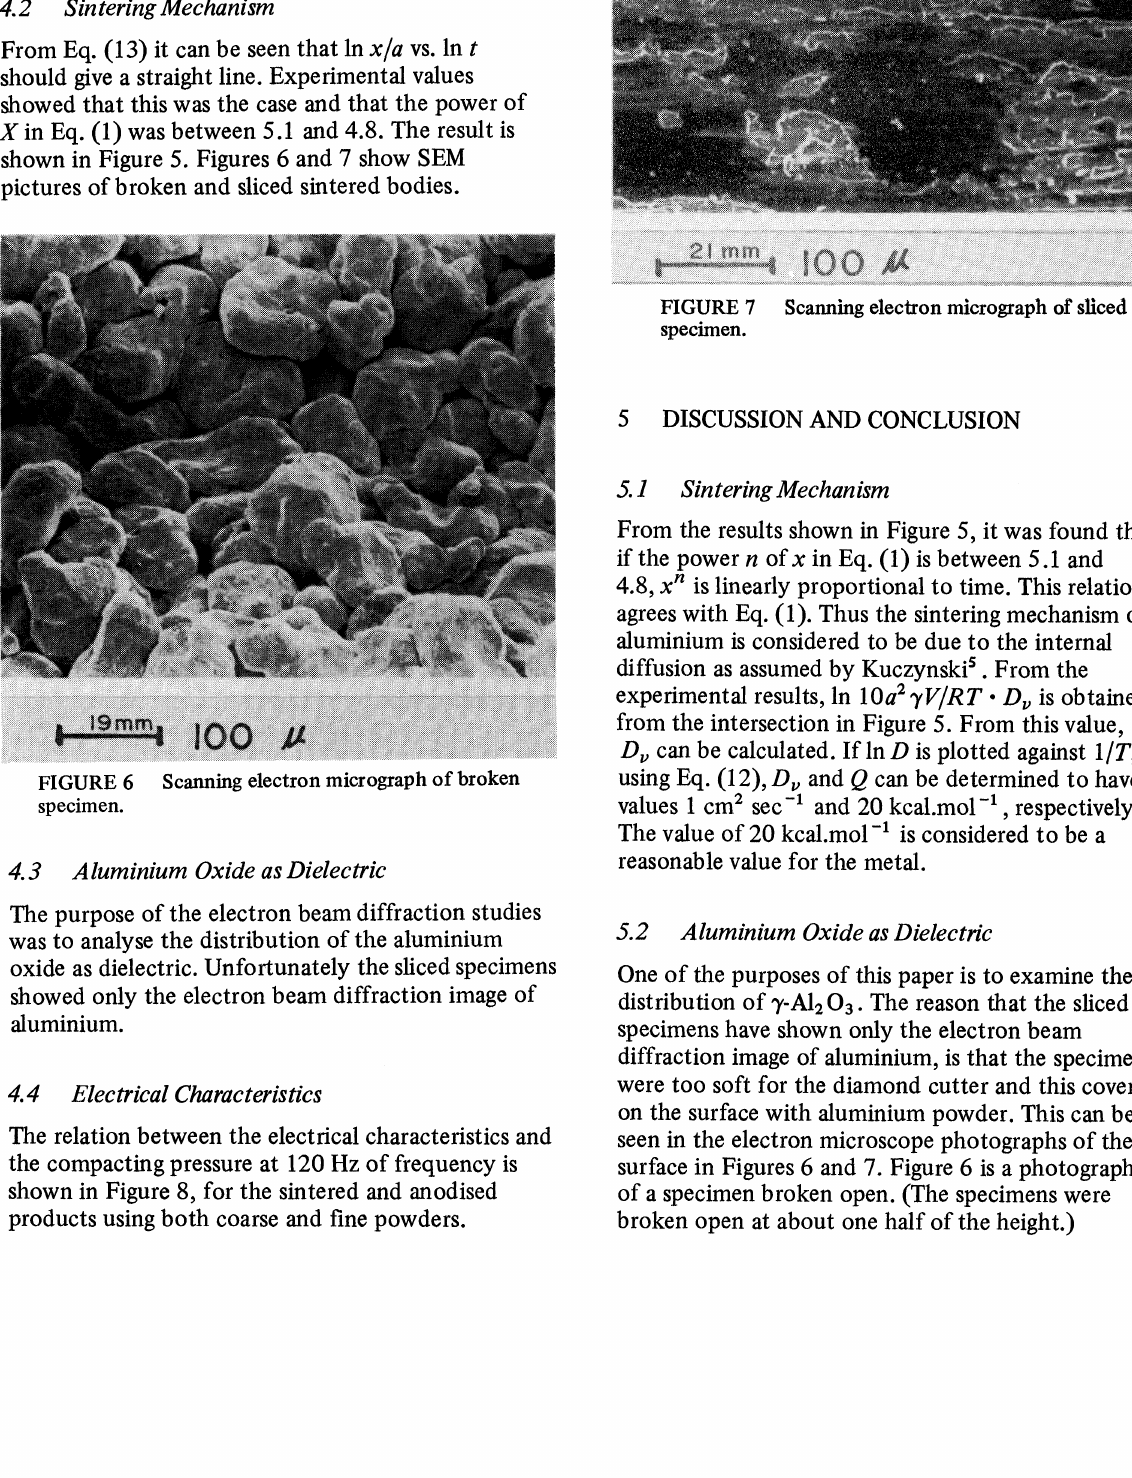
Scanning electron micrograph of sliced specimen.